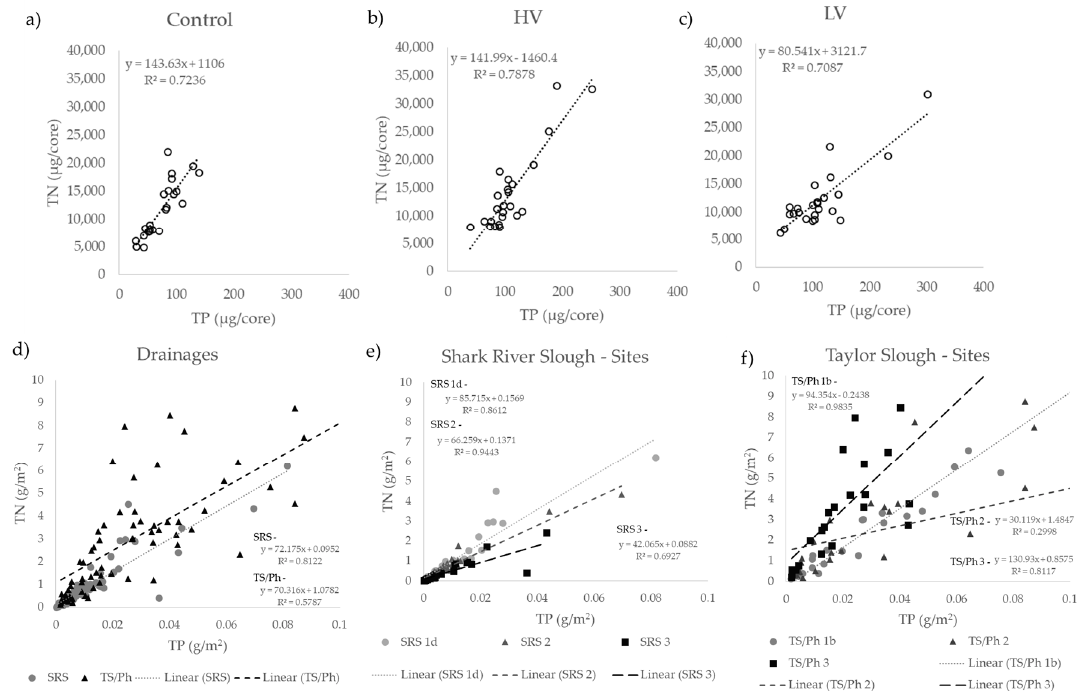
Figure 4. ( a ) Linear regressions of TN vs. TP of long-term data in drainages; linear regressions of TN vs. TP measured in per site (( b ) SRS; ( c ) TS/Ph); linear regressions of TN vs. TP measured from the experiment (( d ) Control; ( e ) high variance (HV) drying-rewetting; ( f ) low-variance (LV) drying-rewetting. Abbreviations as in previous figures.